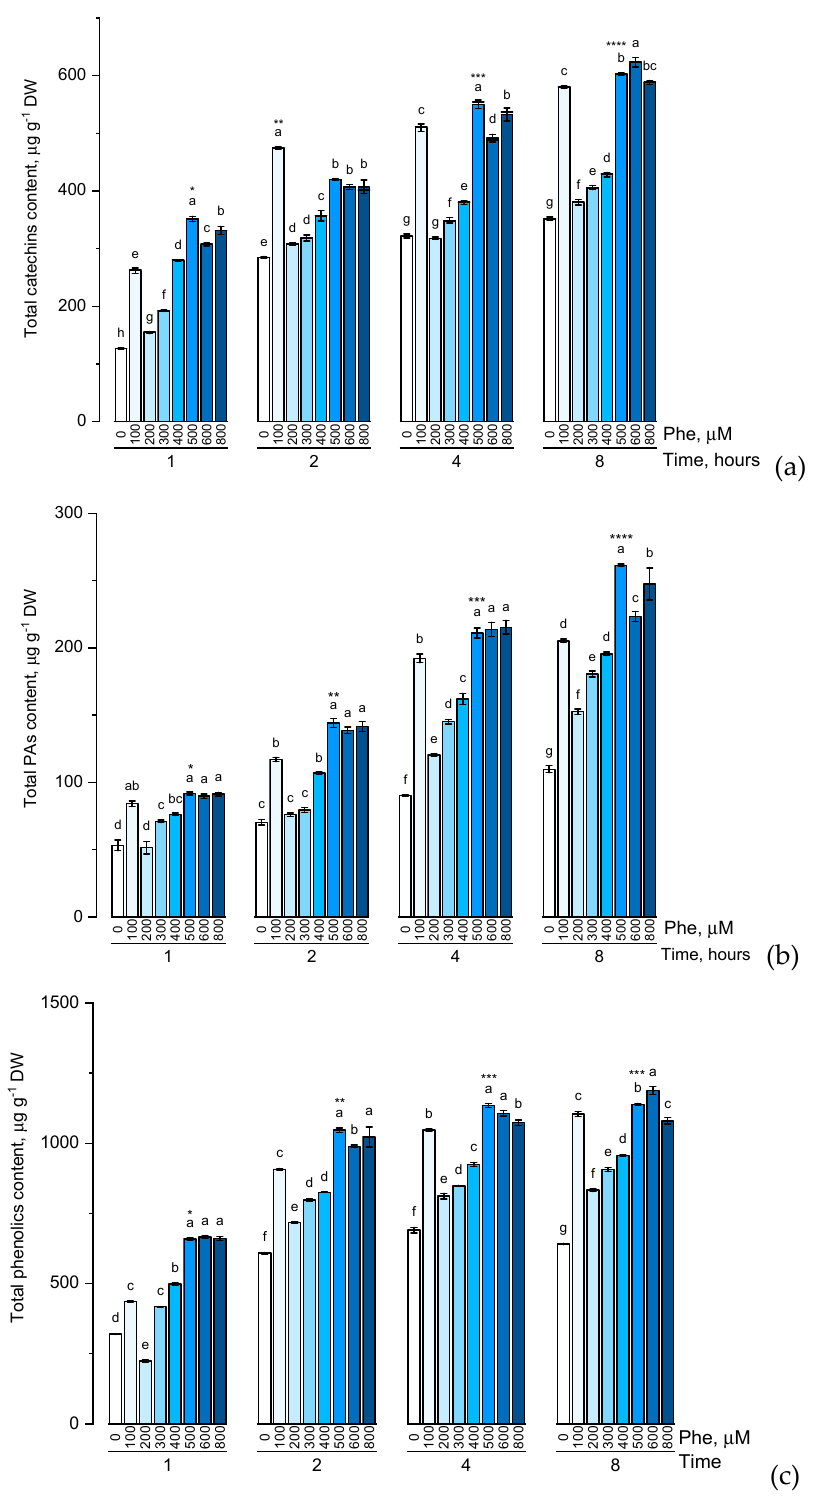
Figure 3. Accumulation of total catechins content ( a ), total proanthocyanidins content ( b ), total phenolic content ( c ) in wheat samples incubated on phenylalanine-enriched medium containing various concentrations of the amino acid (100, 200, 300, 400, 500, 600, and 800 µ M) for 1, 2, 4, 8 h. Bars marked with different letters show significant differences for the defined time of cultivation with phenylalanine; asterisk * indicates significant differences among plants exposed for a different time at 500 µ M ( p ≤ 0.05, Tukey’s test).